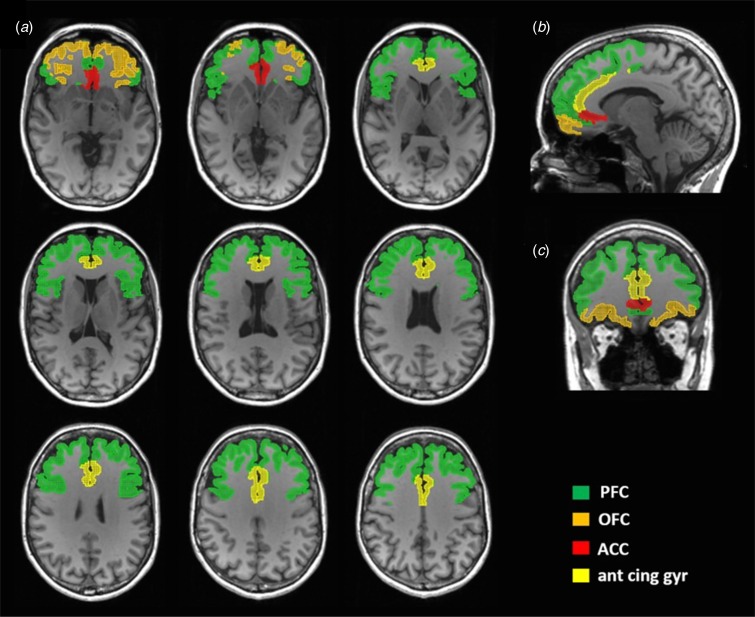
Masks for the frontal cortex. The mask is overlaid on a structural MRI scan and shown in transversal (a), sagittal (b), and coronal (c) views. MRI, magnetic resonance imaging; PFC, prefrontal cortex; OFC, orbitofrontal cortex; ACC, anterior cingulate cortex; ant cing gyr, anterior cingulate gyrus.